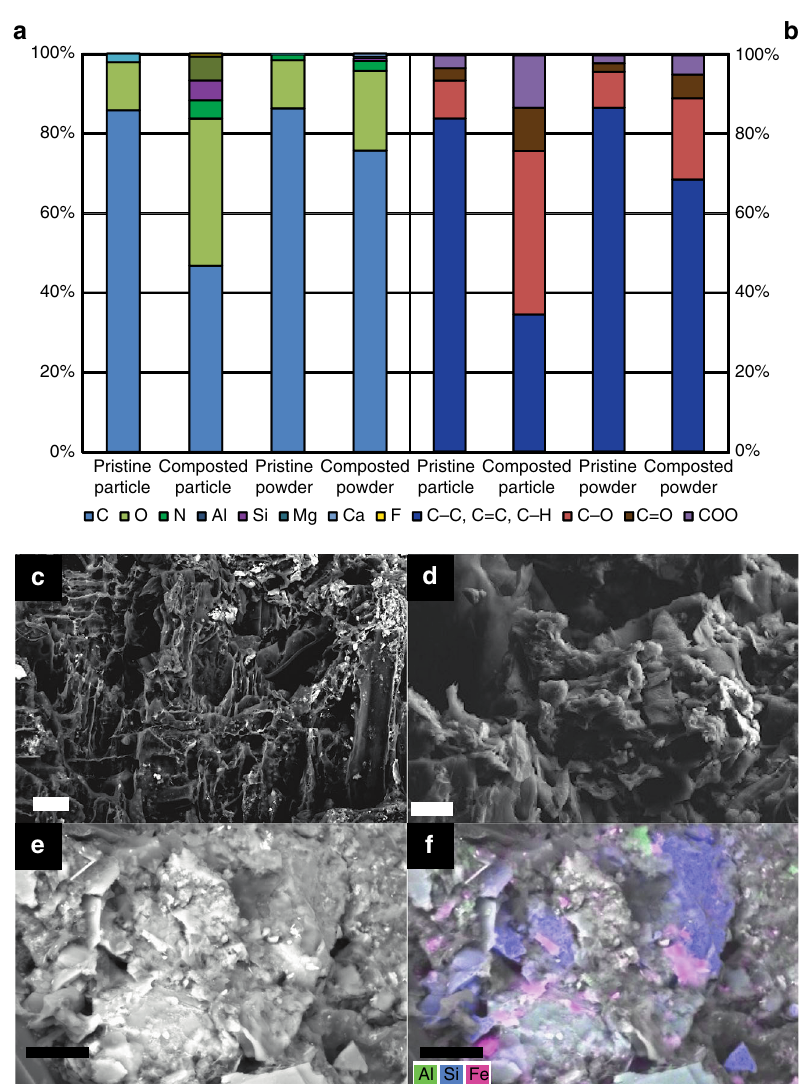
Fig. 2 Identi fi cation of biochar surface modi fi cations induced by co-composting. a Elemental composition of the surface (particle) and the bulk (powder) biochar according to X-ray photoelectron spectroscopy (XPS). b Carbon-containing functional groups according to region scans (higher energy resolution) of the same samples. c – f Scanning electron micrographs of co-composted biochar with c a region with degraded, but still exposed original biochar surfaces showing typical porous structure (scale bar, 20 µ m); d a region of biochar surface partially covered with organic coating (scale bar, 10 µ m); e a region of biochar surface completely covered with organic coating (scale bar, 600 µ m). f map overlay of e showing the heterogeneous distribution of Al (green), Si (blue) and Fe (red) within the organic coating as quanti fi ed by energy-dispersive X-ray